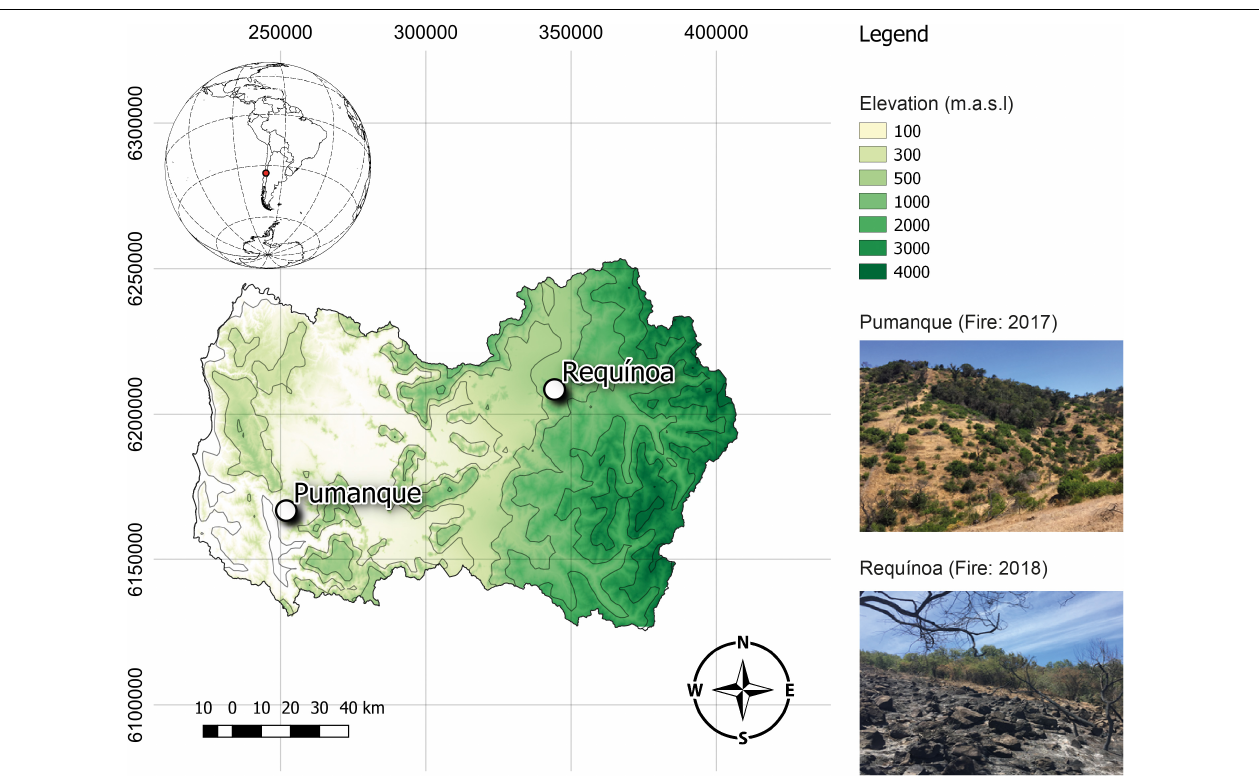
FIGURE 1 | Sampling sites consisting of sclerophyll forests located within the Mediterranean climate zone of Central Chile, in the O’Higgins administrative region. White dots represent the study locations, which were affected by forest fires in January of 2017 (Pumanque) and May of 2018 (Requínoa). Image created using QGIS